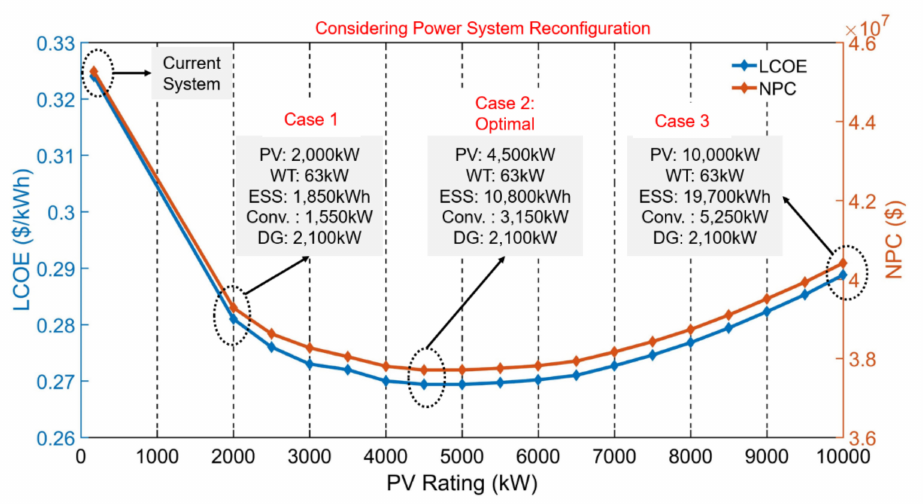
Figure 20. LCOE and NPC for various PV capacities considering power system